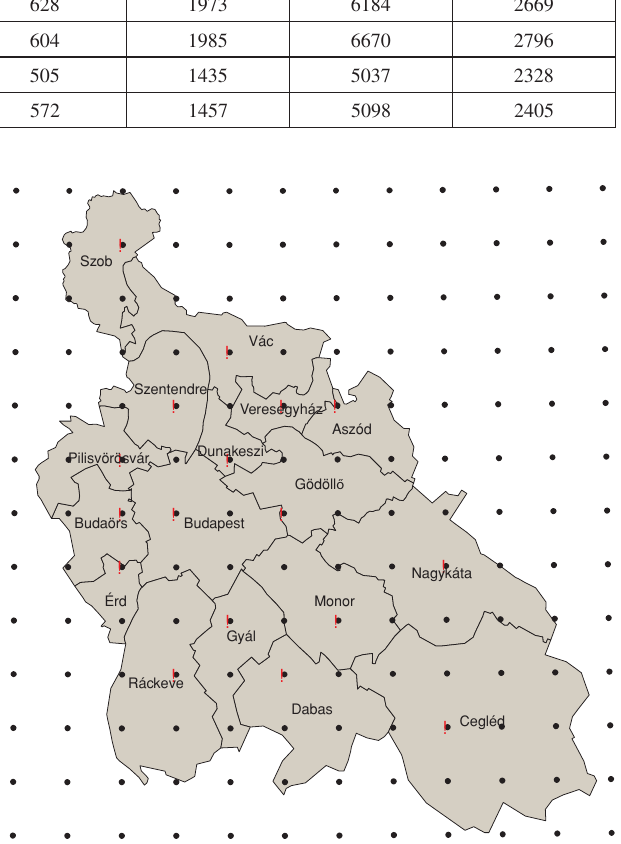
Figure 2. Subregions in Central Hungary and the grid of the RegCM model (highlighted grid points were